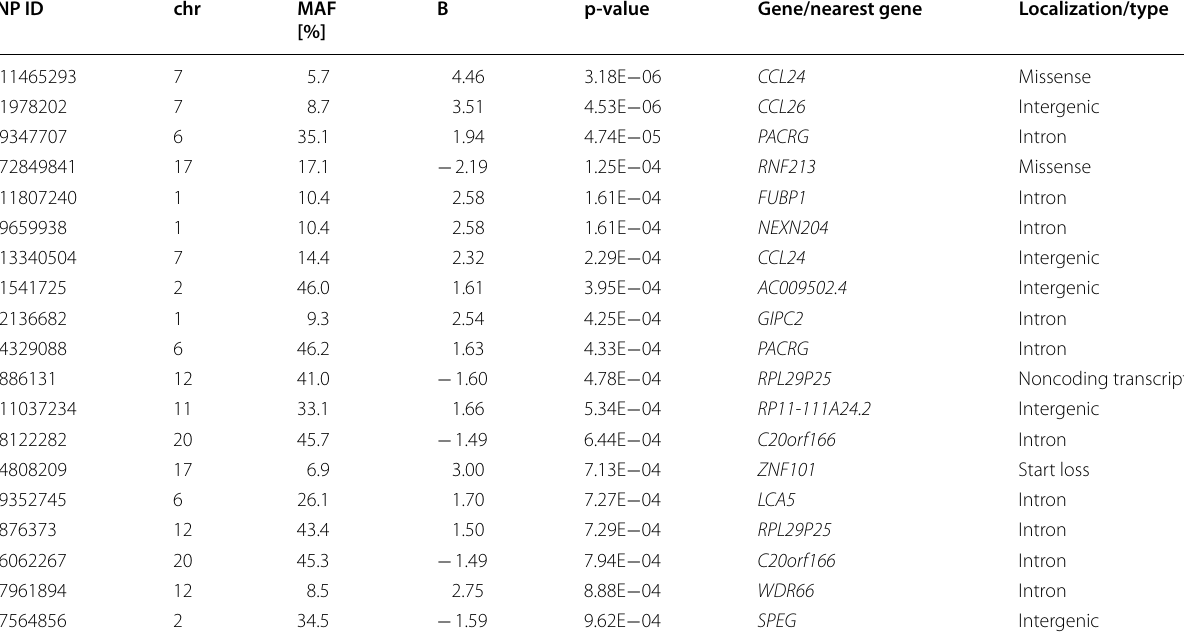
Table 2 The list of variants localized to genes associated with BMI in the GIANT cohort which associate with GWG SNP ID